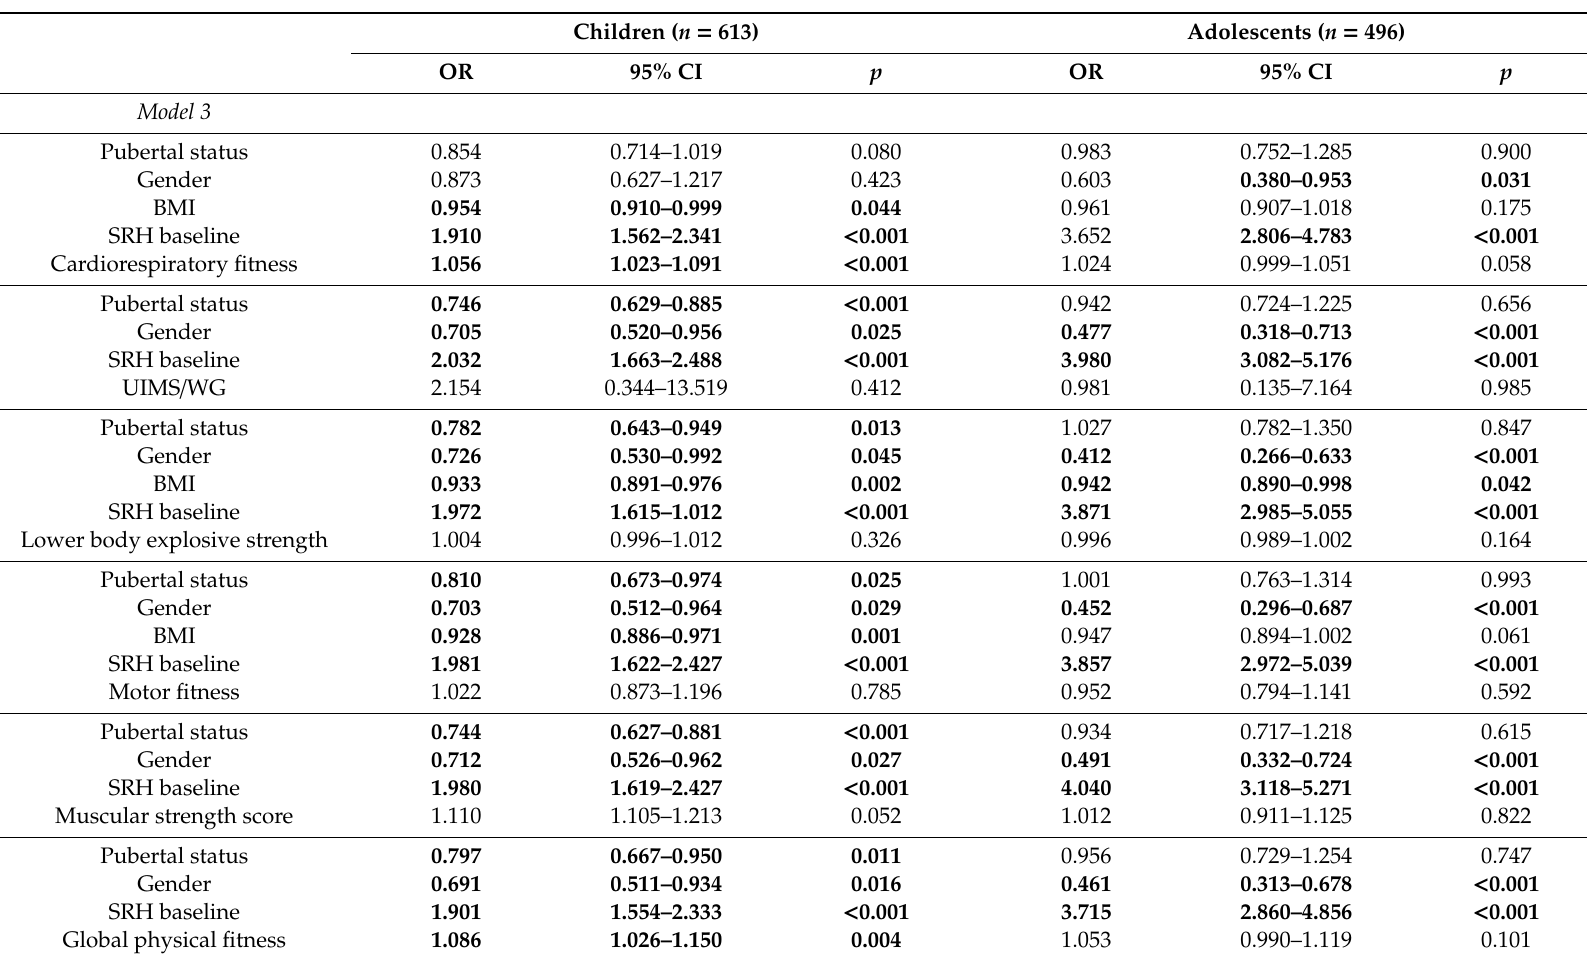
Table 3. Cumulative odd ratios and 95% confidence intervals for having high self-rated health at 2-year follow-up according to physical fitness at